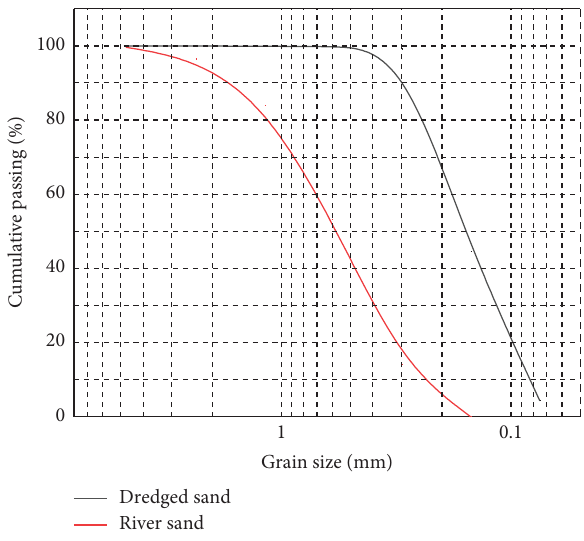
Figure 1: Size distribution of dredged Table 1: Chemical composition analysis results for dredged sand.